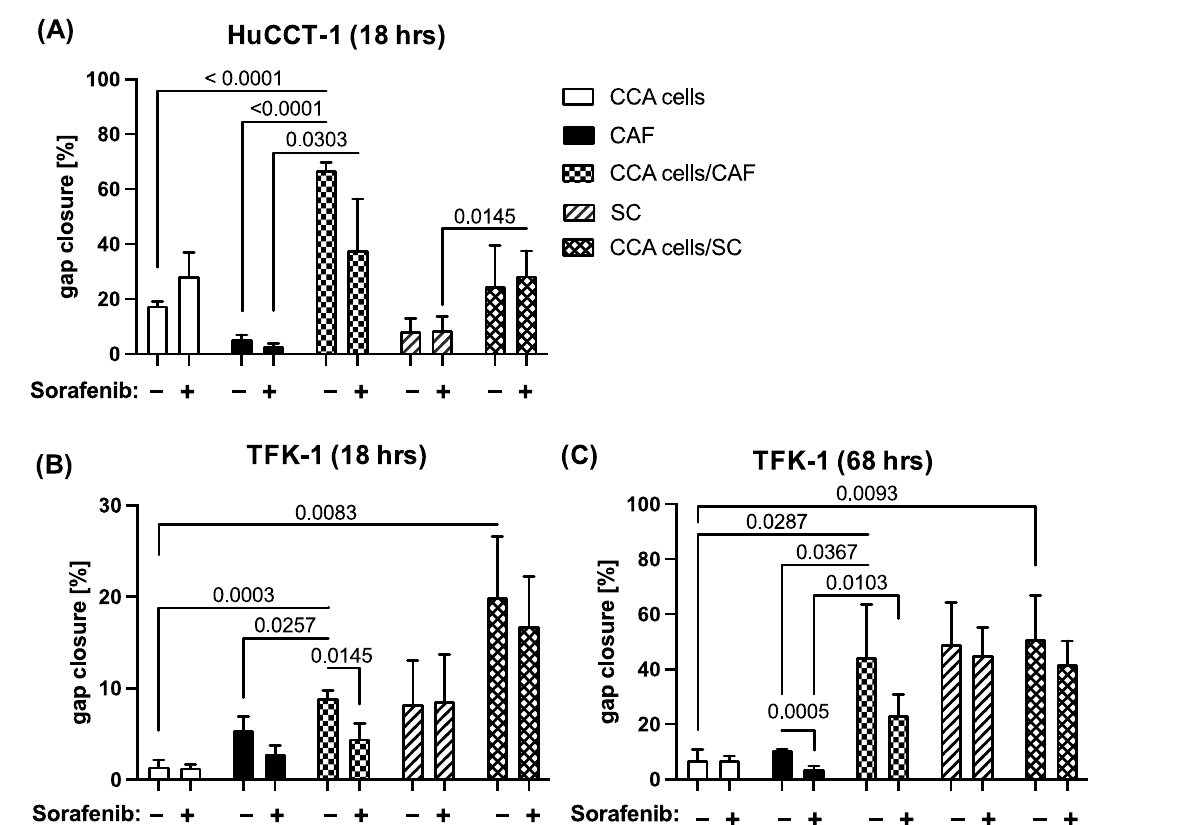
Figure 3. Sorafenib reduces migration of CAF and CAF co-cultivated CCA cells. HuCCT-1 and TFK-1 cells were cultured either alone or together with CAF or SC in 4 chamber ibidi slides. Mono-cultured CAF and SC were cultured in parallel as control. Additionally, cells were either left untreated or treated with 1 µM Sorafenib. ( A ) Gap closure of mono- and co-cultures with HuCCT-1 cells was analyzed after 18 h and those with TFK-1 cells after ( B ) 18 h and ( C ) 68 h. Data are presented as % gap closure normalized to t= 0 h and as mean and standard deviation of 3 independent experiments. Statistical significances are indicated in the figure.